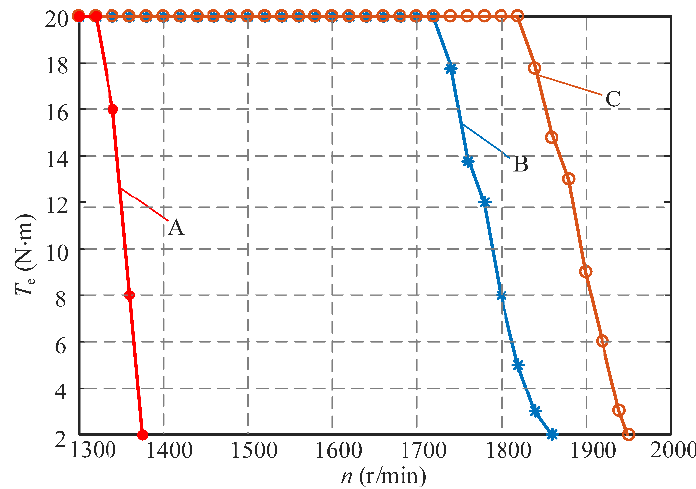
Figure 9. Simulation diagram of motor torque speed characteristic curve.